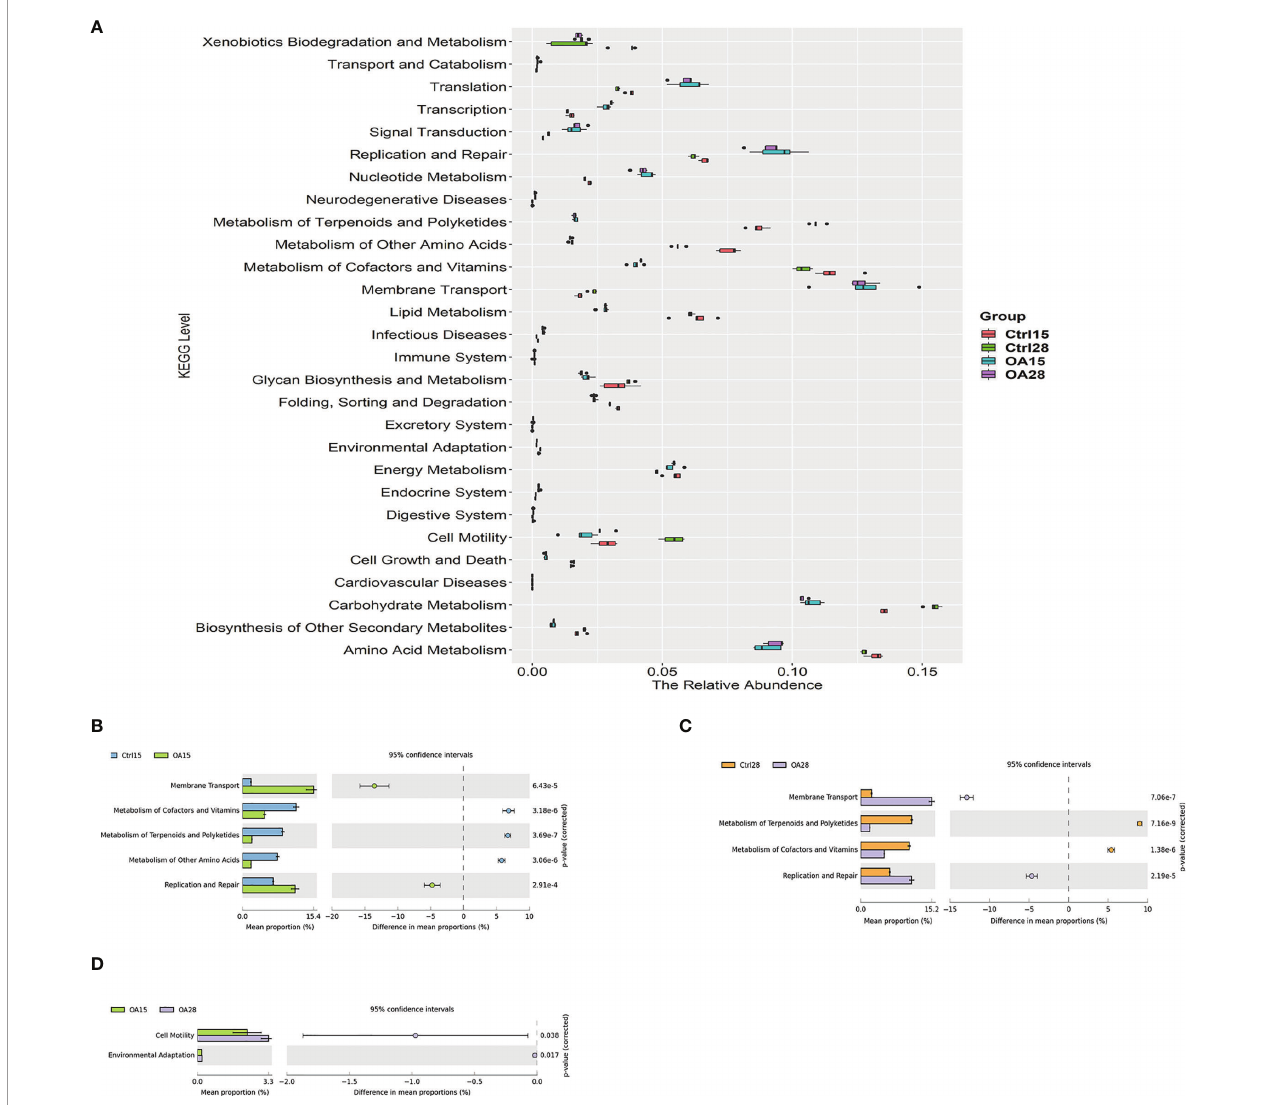
FIGURE 9 | Comparisons of the predominant gene pathways of the bacterial microbiota in different groups as predicted by PICRUSt. The box diagram describes the relative abundance in each group (A) . The differences of metabolism among the Ctrl15 group, Ctrl28 group, and the fi rst feeding L.casei groups OA15 and OA28 were analyzed by using STAMP software with two-sided Student ’ s t-test. Ctrl15 group vs. OA15 group (B) , Ctrl28 group vs. OA28 group (C), and OA15 group vs. OA28 group (D)